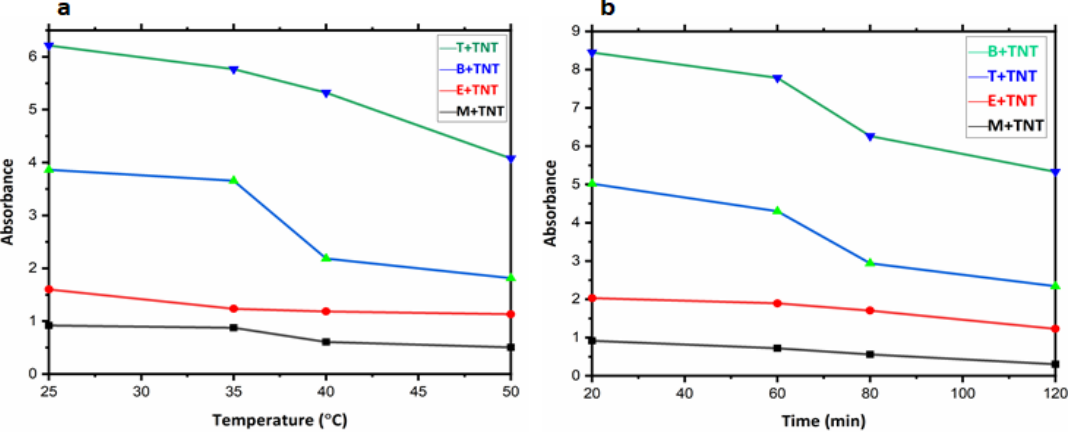
Figure 8. ( a ) Decrease in absorbance as a result of increase in temperature of TNT solutions (1.0 g Fe 3 O 4 NHS, 60 ppm TNT solution), ( b ) Effect of contact time between adsorbate and adsorbent result in decrease in absorbance for TNT solutions (1.0 g Fe 3 O 4 NHS).